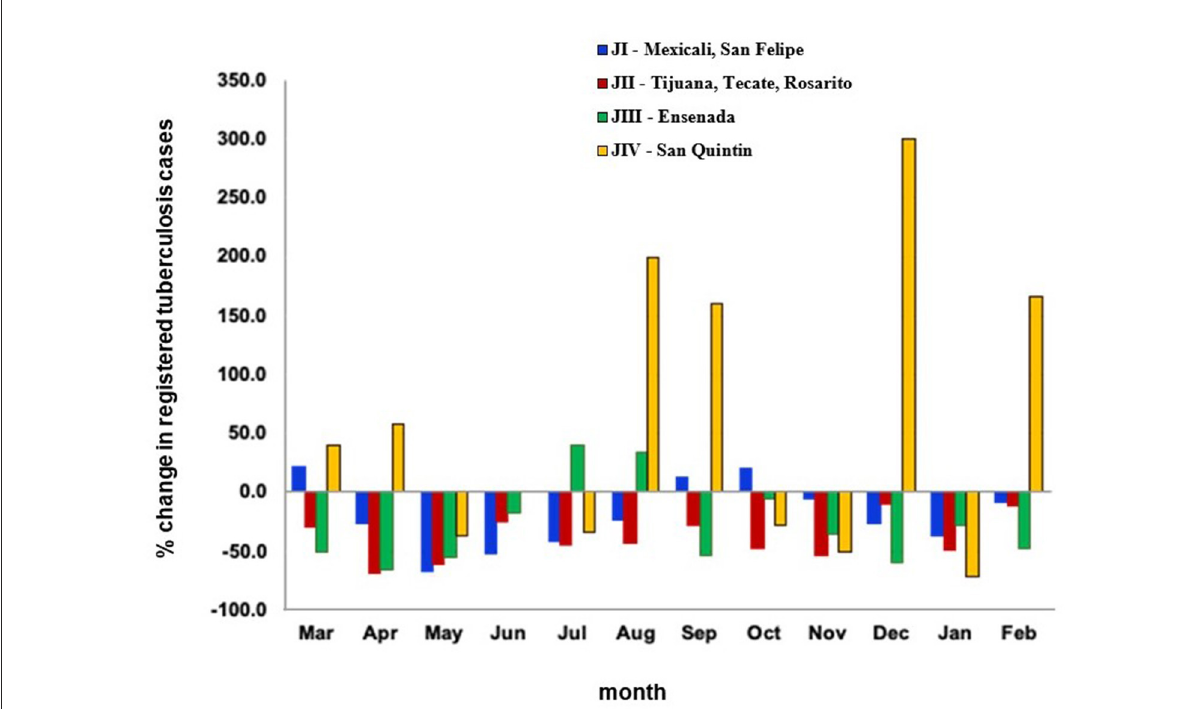
FIGURE3 Change in the proportion of tuberculosis cases registered by month and health jurisdiction between the year before and the first year during the COVID-19 pandemic, Baja California, México, 2019–2021. Data source: Mexico Ministry of Health management information system (https://